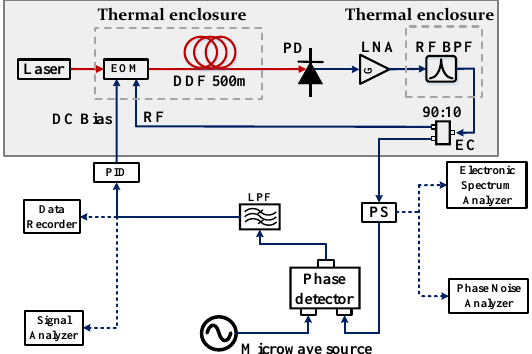
Figure 12. The schematic diagram of the long-term frequency stabilization for OEO based on temperature control and PLL techniques. EOM: electro-optical modulator. DDF: dispersion deduced fiber. PD: photodiode. LNA: low noise amplifier. BPF: band-pass filter. EC: electrical coupler. PS: power splitter. LPF: low-pass filter. PID: proportional-integral-derivative. Reprinted with permission from Ref. [48], IEEE, 2018 .